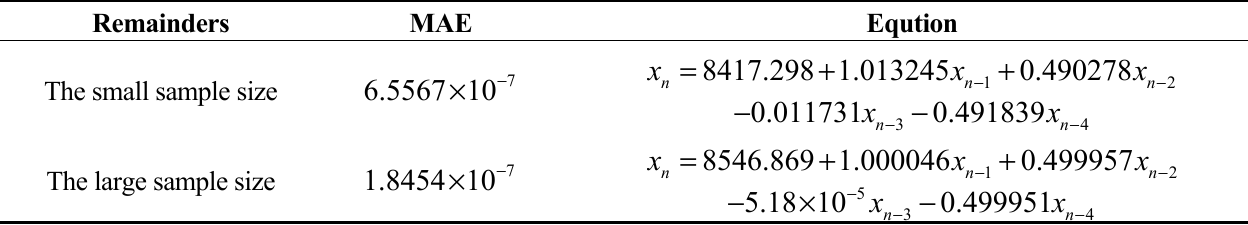
Table 2. Summary of results of the AR forecasting model for